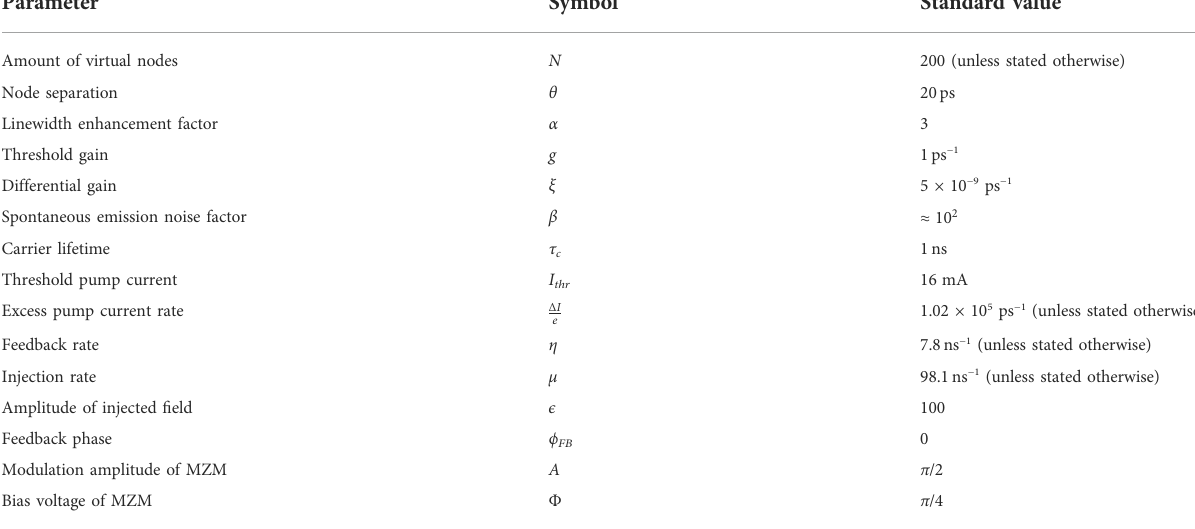
TABLE 1 Parameters used in the